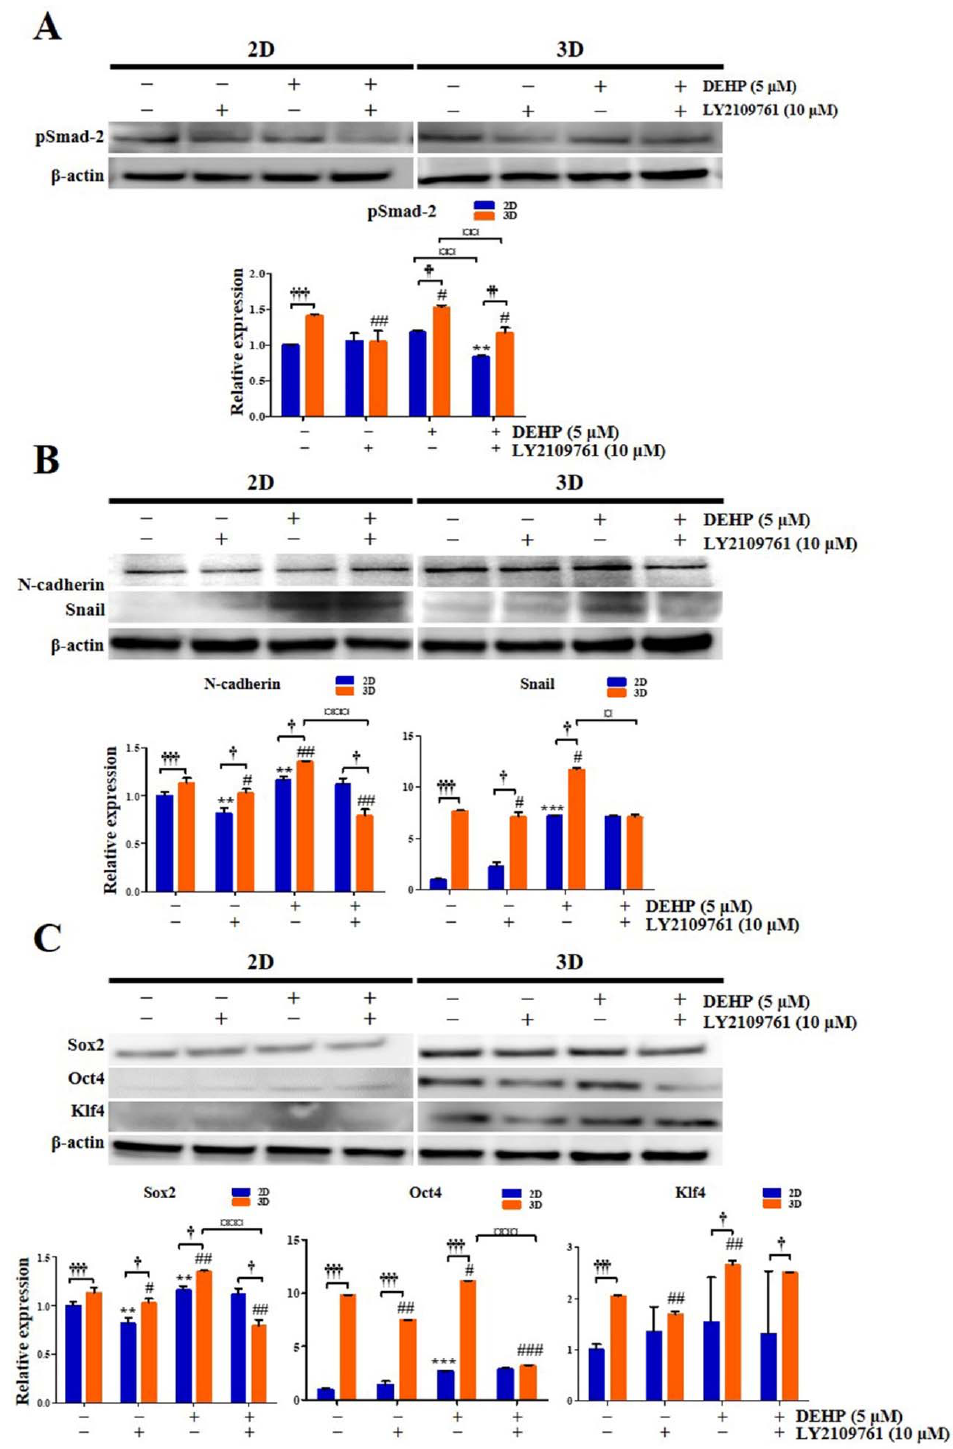
Figure 12. Stemness characteristics of human endometrial epithelial cells are augmented after di-(2-ethylhexyl) phthalate (DEHP) treatment in 3D culture as detected using Western blot analysis. ( A ) pSMAD-2; ( B ) N-cadherin and SNAIL; ( C ) SOX2, OCT4, and KLF4 protein expression levels. β -actin was used as the internal loading control for data normalization. All data are expressed as relative values against their respective control group. Data represent the mean ± standard deviation of three independent experiments. ** p < 0.01 and *** p < 0.001; # p < 0.05, ## p < 0.01, and ### p < 0.001; † p < 0.05, †† p < 0.01 and ††† p < 0.001; ¤ p < 0.05, ¤¤ p < 0.01 and ¤¤¤ p <